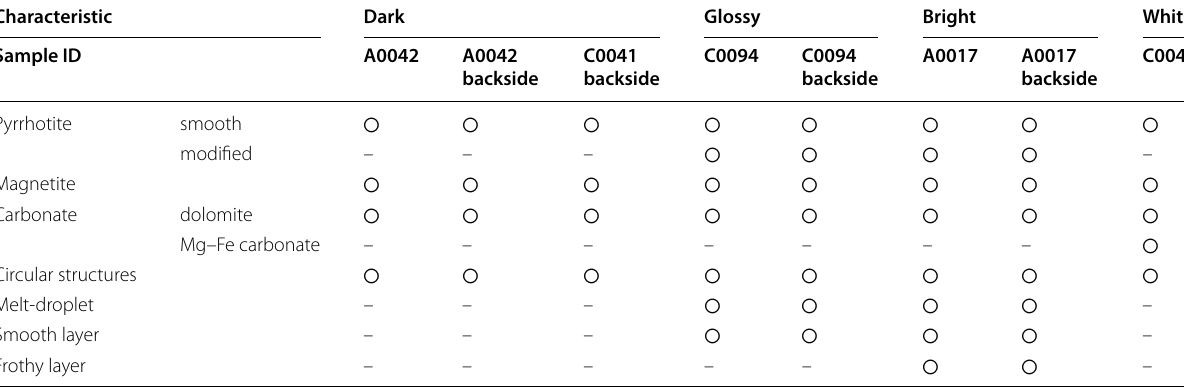
Table 2 SEM observation and XRD results of JAXA‑DD